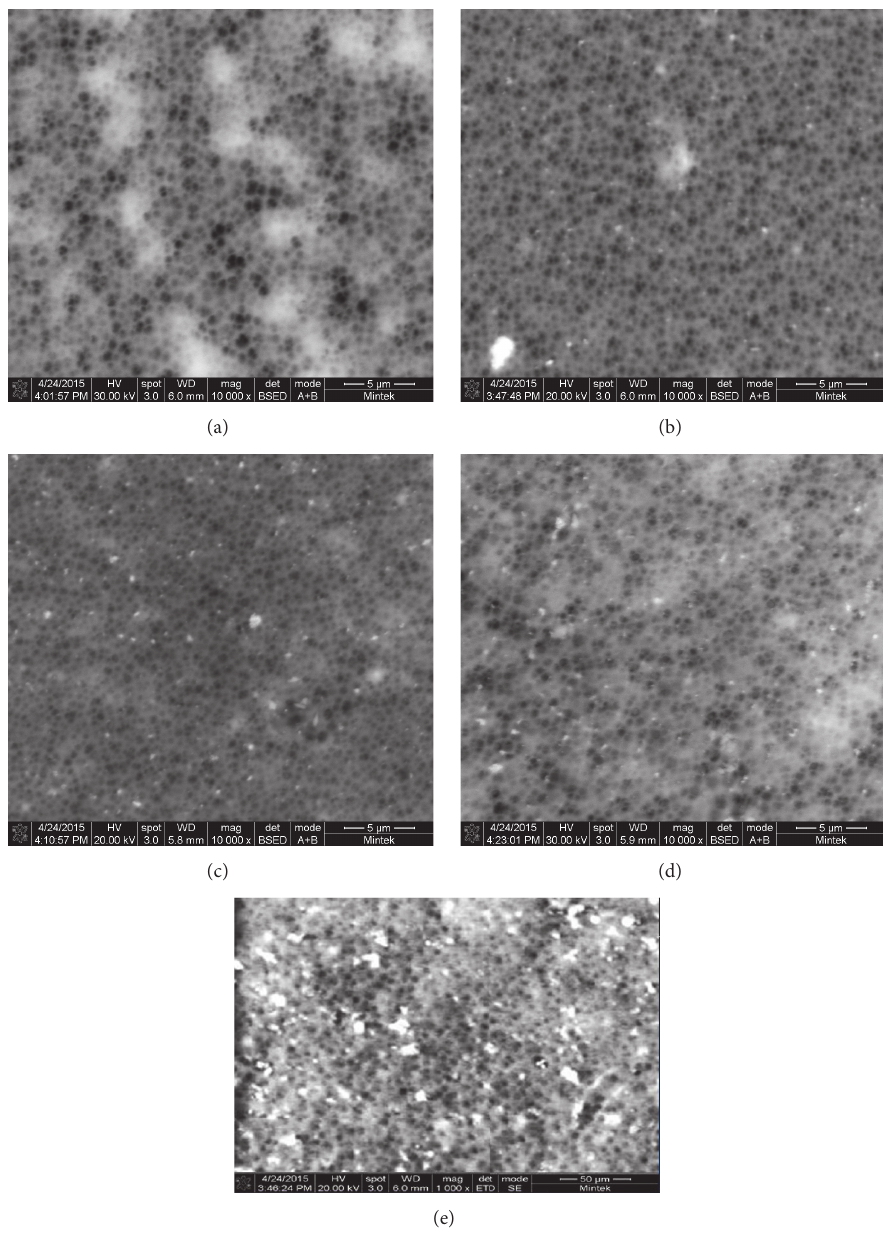
Figure 2: SEM images of (a) pure PES; (b) PES/ZnO (0.5%); (c) PES/ZnO (1.0%); (d) PES/ZnO (1.5%); (e) PES/ZnO (2.0%).